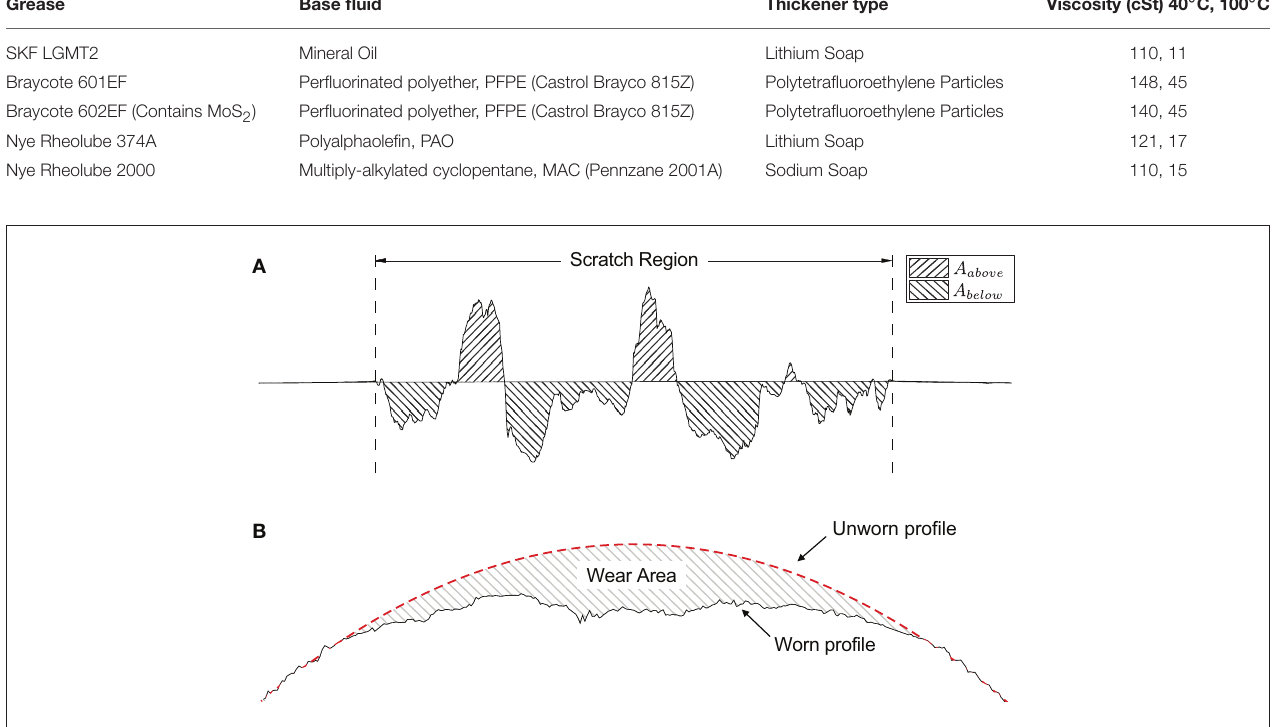
Images of the worn surfaces were obtained from a